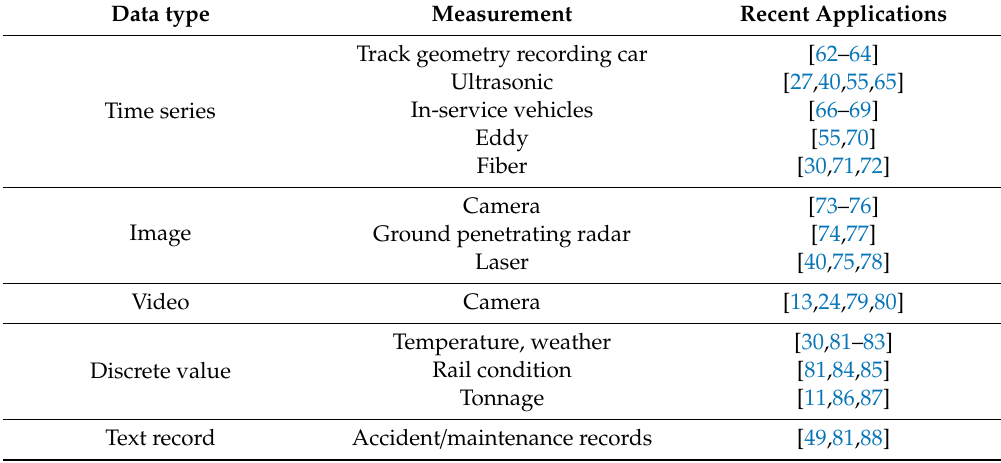
Table 4. Track measurement data types and applications in railway track